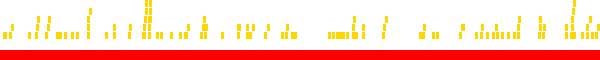
A graphic map of the distribution of the recognized target DNA sites by the 114 multi-Zif-arrays, along the entire length of the SIV/HIV-pol-gene. The figure offers a detailed graphics illustration of the distribution of target DNA sites along the full 3,182 bp lengths of the SIV/HIV-pol gene recognized by all 114 multi-Zif-arrays. For details, see Table 1 and Additional file 1.